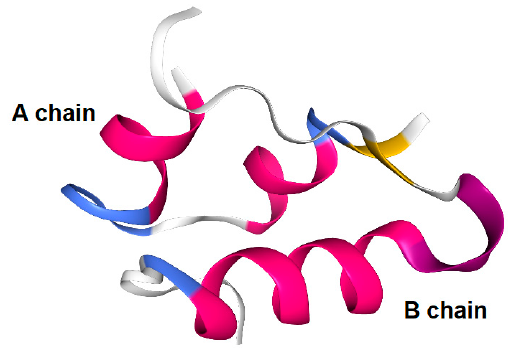
Figure 5. Human insulin X-ray crystal structure (3I40).